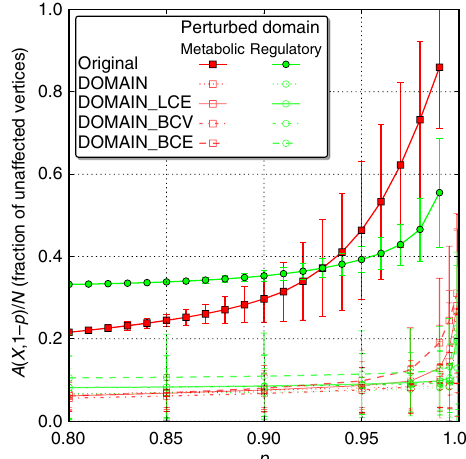
Fig. 5 Fractions of unaffected vertices of the integrative E. coli network and its randomized versions for distinct localized perturbations. Per initial perturbation size, q = 1 − p , 5000 runs were averaged for the original network ( fi lled markers ) and the four randomization schemes ( open markers ), where in turn, 500 realizations are considered for each scheme. Initial perturbations in the gene regulatory domain are presented as green dots , while perturbations initiated in the metabolic domain are given as red squares . The error bars indicate s.d. (results for randomized realizations have been